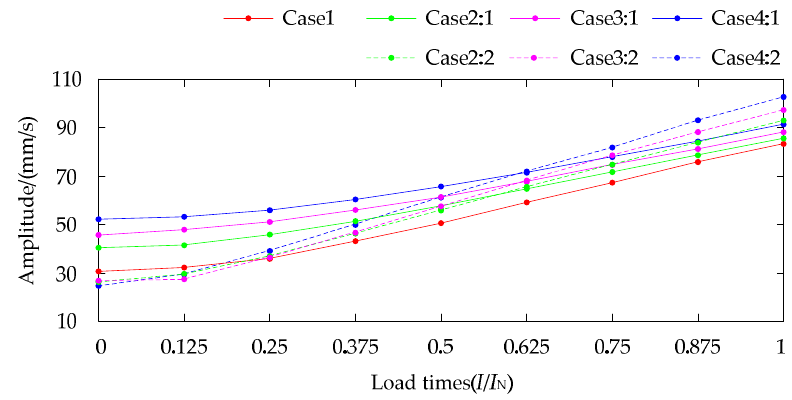
Figure 8. The velocity of stator vibration with load times.